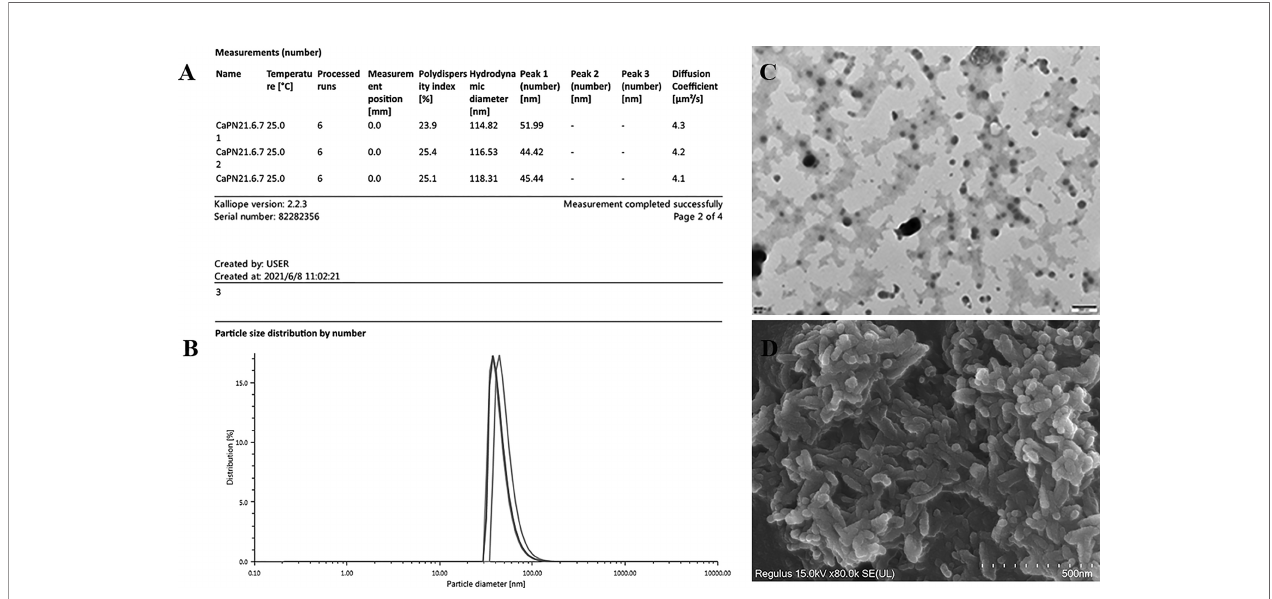
FIGURE 2 | Characterization of calcium phosphate nanoparticles (CaPNs). (A) Morphology was observed using scanning electron microscopy (SEM). (B) Nanoparticle size and distribution were observed using transmission electron microscopy (TEM). (C) Nanoparticle size and diffusion coef fi cient were analyzed using an Anton Paar Litesizer 500. (D) Particle size distribution by number is shown.